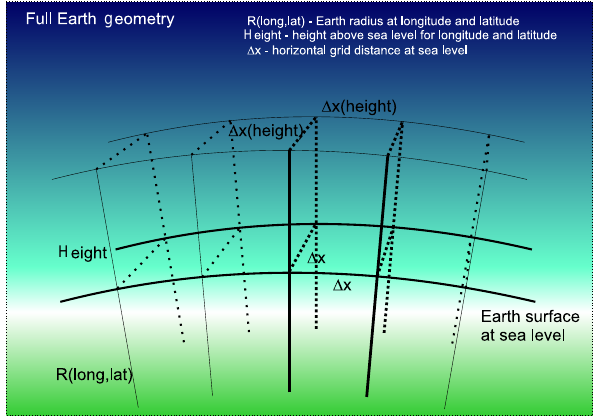
Figure 3. Schematic of 3-D gridding to compute horizontally re- solved wind fields including the Earth